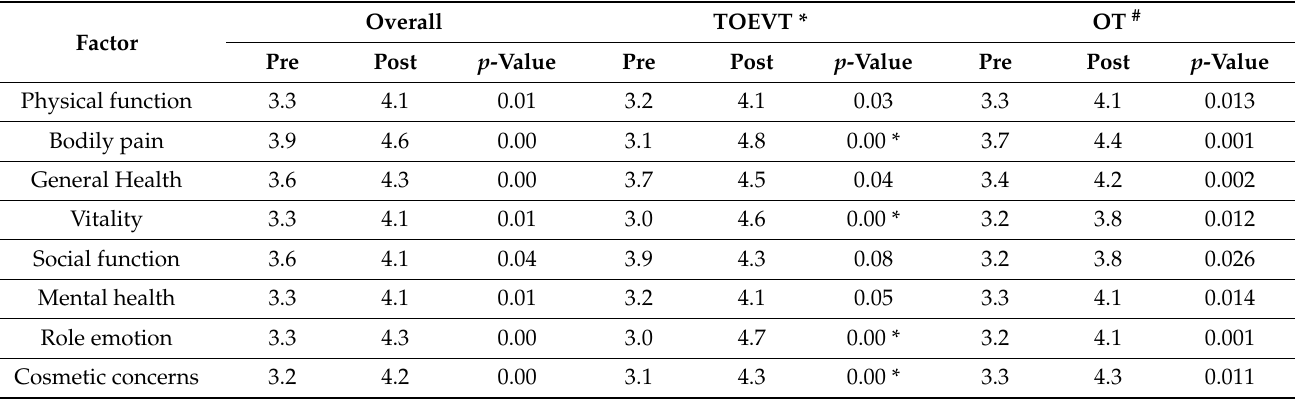
Table 4. A comparison of the quality of life pre-post transoral endoscopic vestibular and open thyroidectomy ( n = 59).